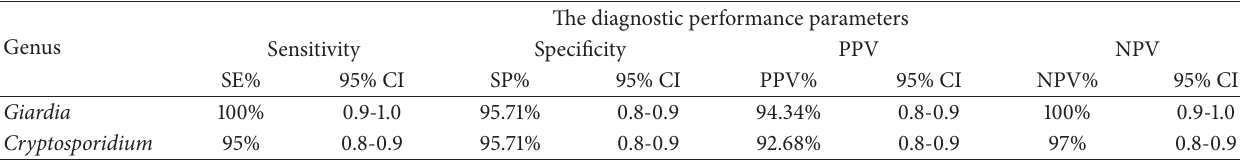
Table 2: The diagnostic performance of the ELISA kit for Cryptosporidium and Giardia.